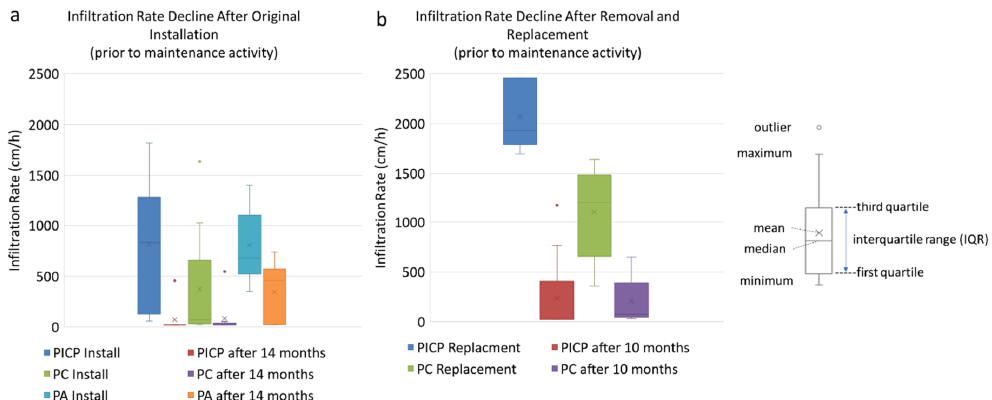
Figure 8. Decline in infiltration rates during the period without maintenance activity following ( a ) initial surface installation and ( b ) surface replacement of the permeable interlocking pavers (PICP), pervious concrete (PC), and porous asphalt (PA) test plots (cm/h, centimeters per hour). In the summer of 2016, the surfaces of the PICP and PC were removed and replaced. The